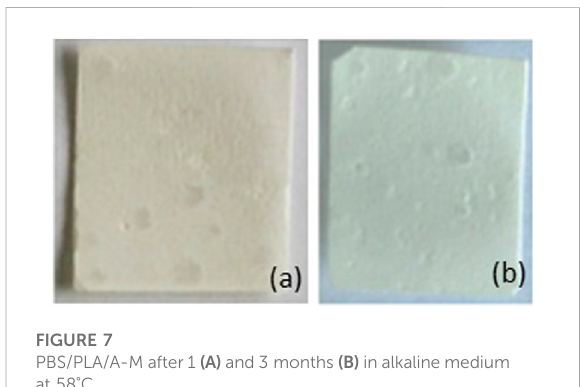
FIGURE 7 PBS/PLA/A-M after 1 (A) and 3 months (B) in alkaline medium at 58 °